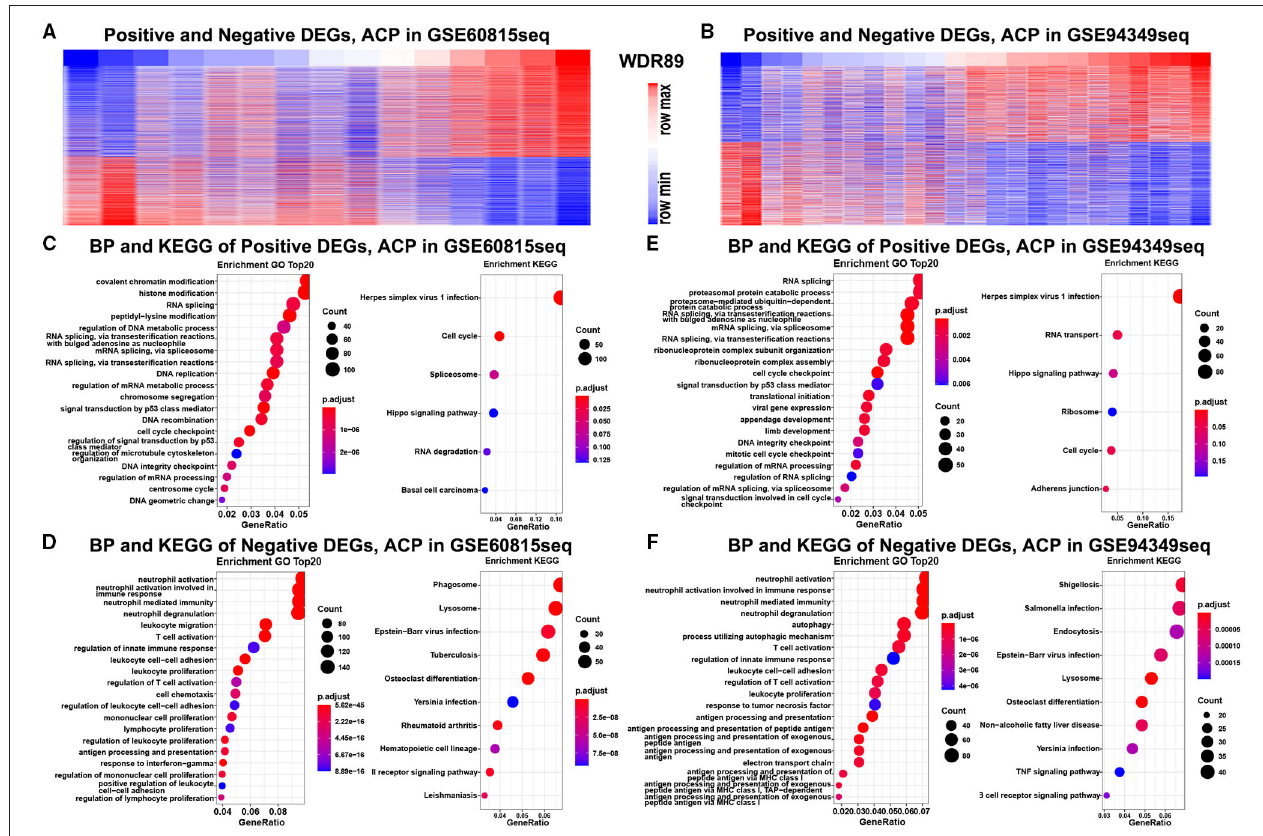
FIGURE 10 | GO and KEGG analysis of WDR89-associated genes in ACPs. (A,B) Heatmap for genes most relevant to WDR89 generated by Pearson correlation analysis in the GSE68015 and GSE94349 databases. (C–F) GO and KEGG enrichment analysis of genes most relevant to